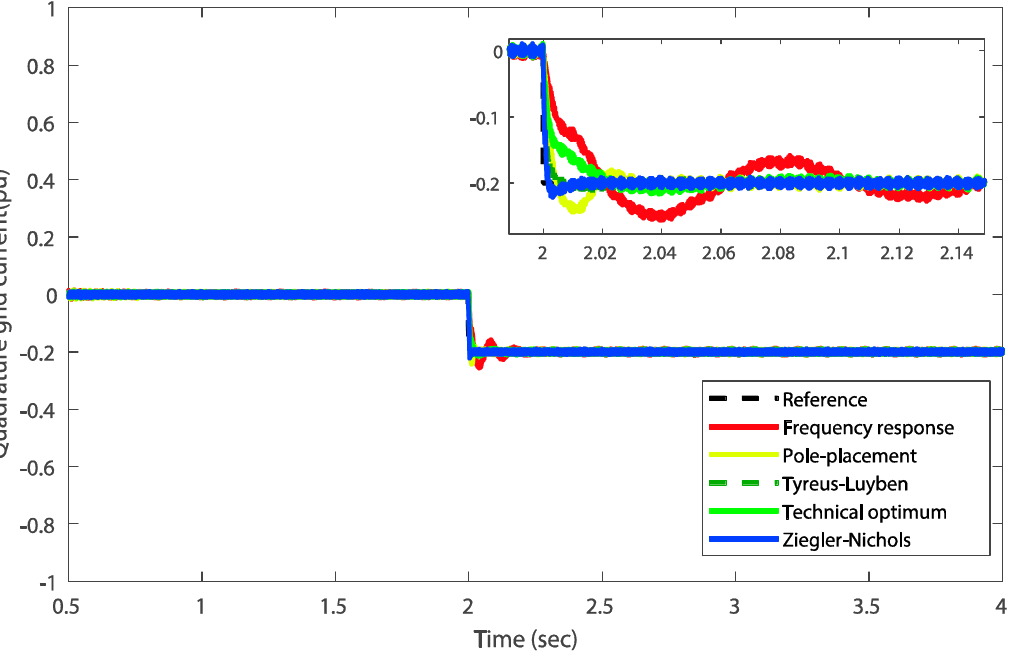
Figure 10. Quadrature grid current responses against a step change for different-tuned PI controllers.